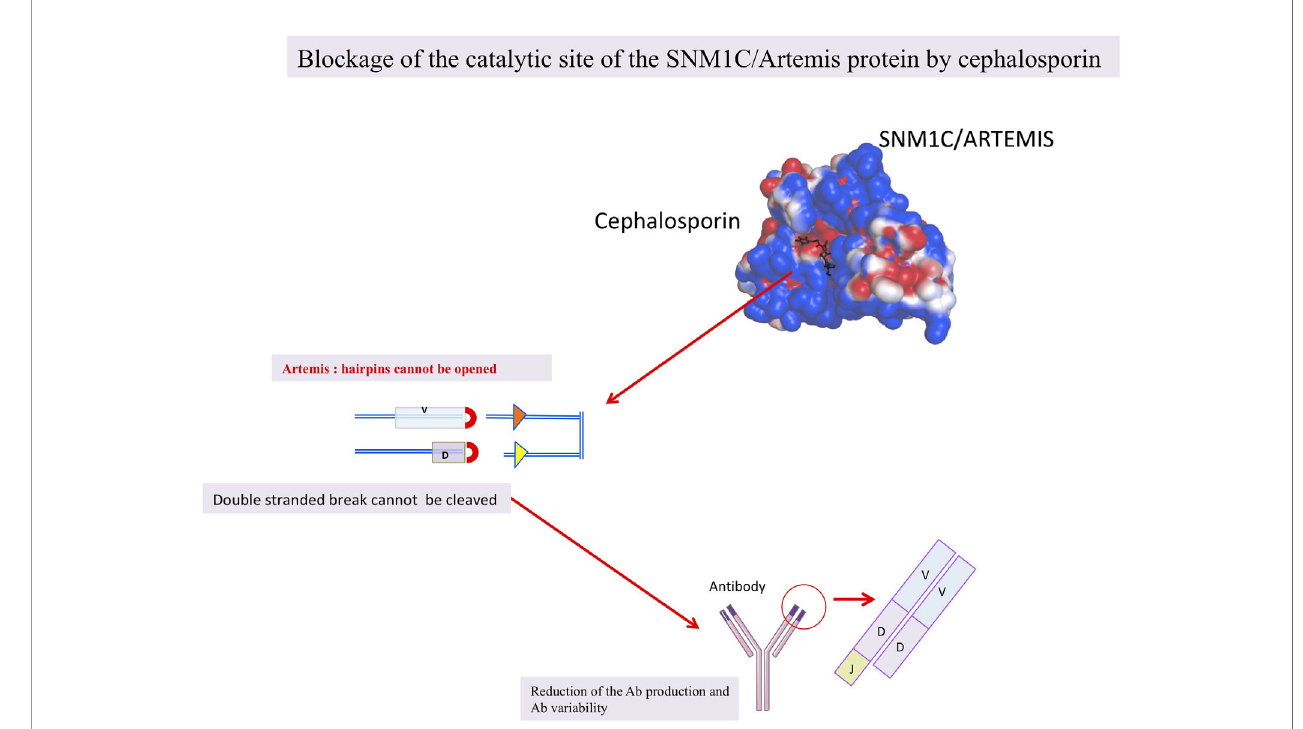
FIGURE 3 | The hypothesis shematized: b -lactam antibiotics blocking the SNM1C/Artemis